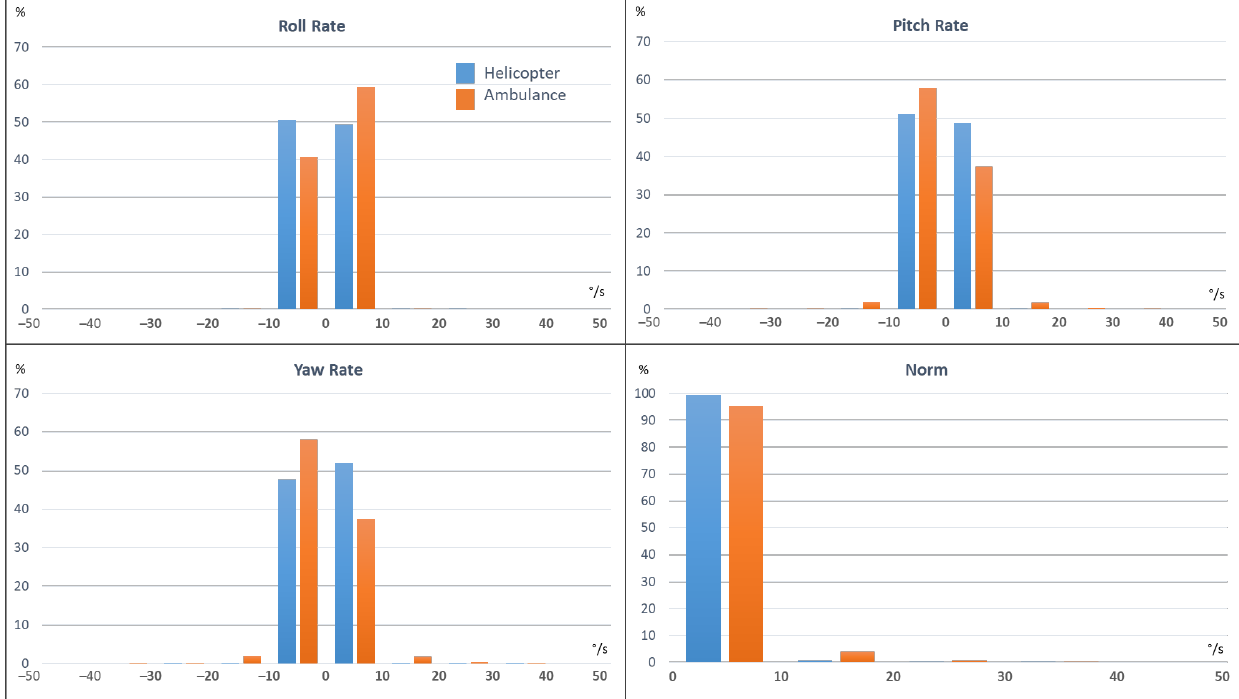
Figure 9 . Comparison of rotation rate levels between ambulance and helicopter